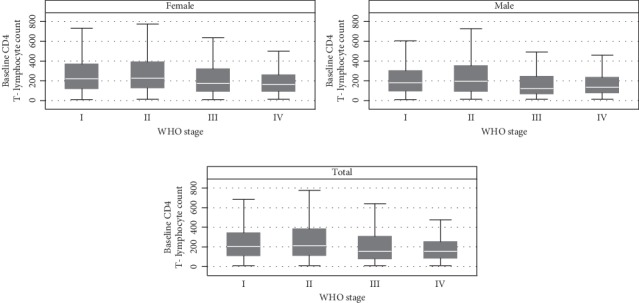
Box-and-whisker plot showing the median and range distribution of CD4+ T-lymphocyte counts at the different WHO clinical stages of HIV/AIDS among ART-naïve HIV-infected adolescents and adults in northern Ethiopia, n = 19525.